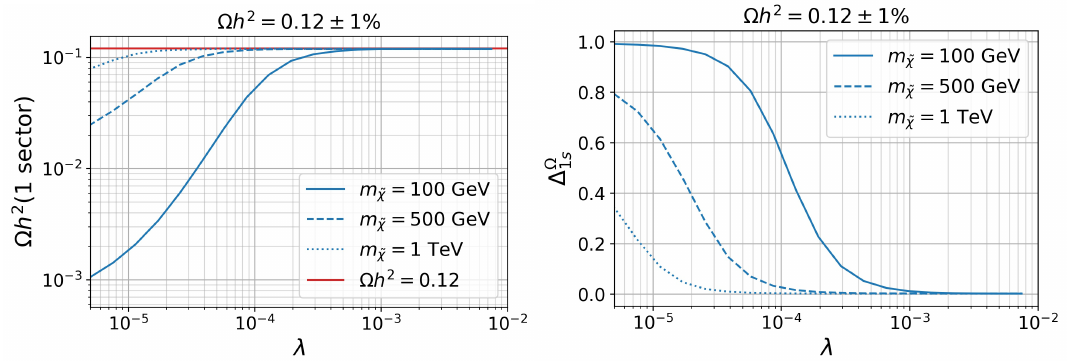
as defined in Eq. (28). 2 s